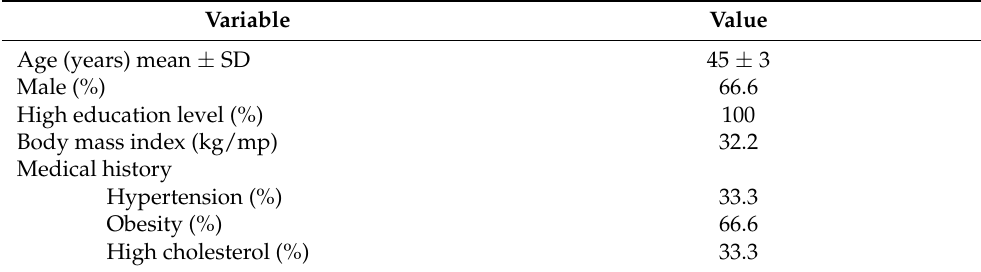
Table 1. The subjects’ characteristics and baseline measures.